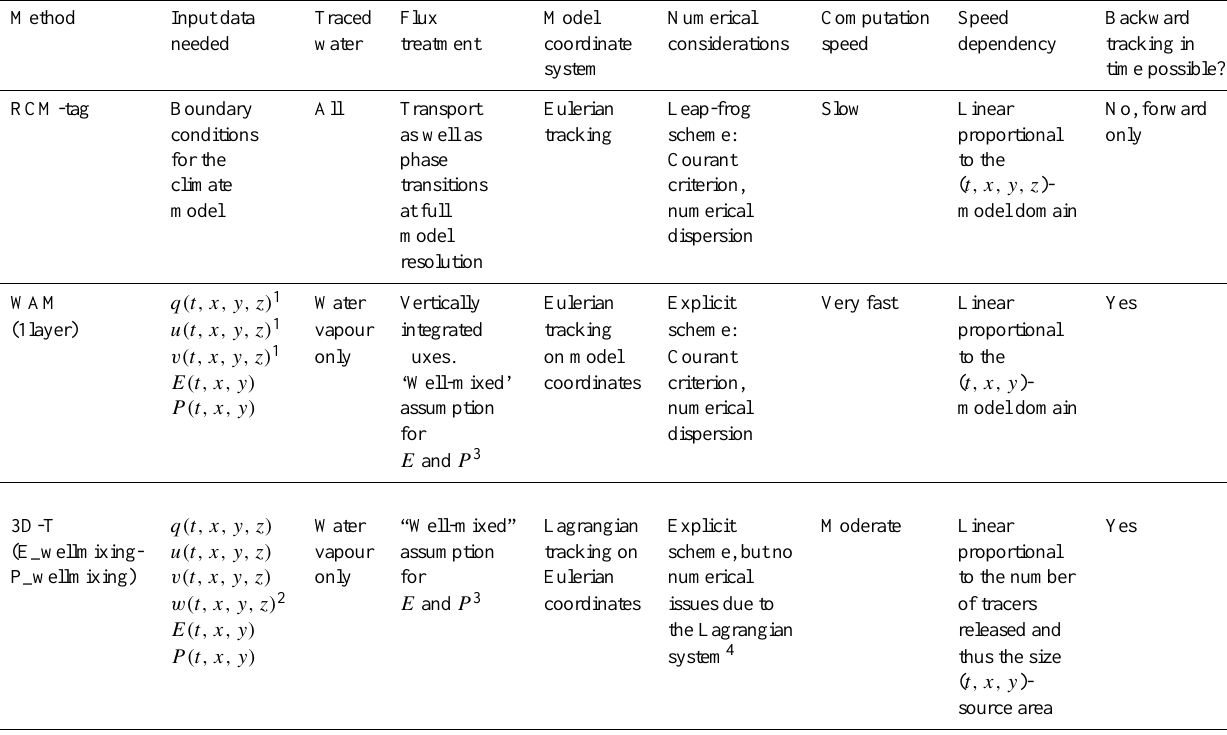
Table 1. Characteristics of the tracking methods. q is specific humidity, u is zonal wind speed, v is meridional wind speed, w is vertical wind speed, P is precipitation and E is evaporation. In case the input data is given on pressure levels instead of model levels then surface pressure is required as well for WAM and 3D-T. For more information on the methods: RCM-tag (Knoche and Kunstmann, 2013), WAM (van der Ent et al., 2010; van der Ent and Savenije, 2011; Keys et al., 2012), and 3D-T (Tuinenburg et al.,